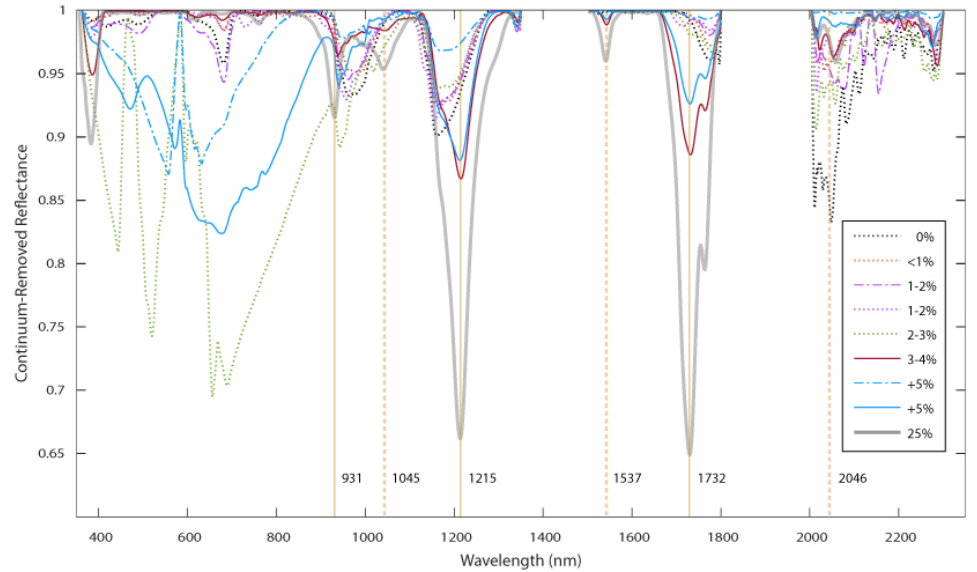
Figure 6. Average continuum-removed reflectance of representative quadrats collected on Cocos (Keeling) Island beaches, including a quadrat with no MPD, quadrats with varying MPD abundance (<1%, 1–2%, 2–3%, 3–4% and +5%) and an intentionally created quadrat with 25% surface cover. Ver- tical lines show the position of absorption features identified in the literature [30]. Plastic absorption features at 931 nm, 1045 nm and 2046 nm were not readily distinguishable in the in situ quadrats when compared to the quadrat with no MPD. The 1215 nm feature and the 1732 nm features are distinguishable when compared to the sand-only